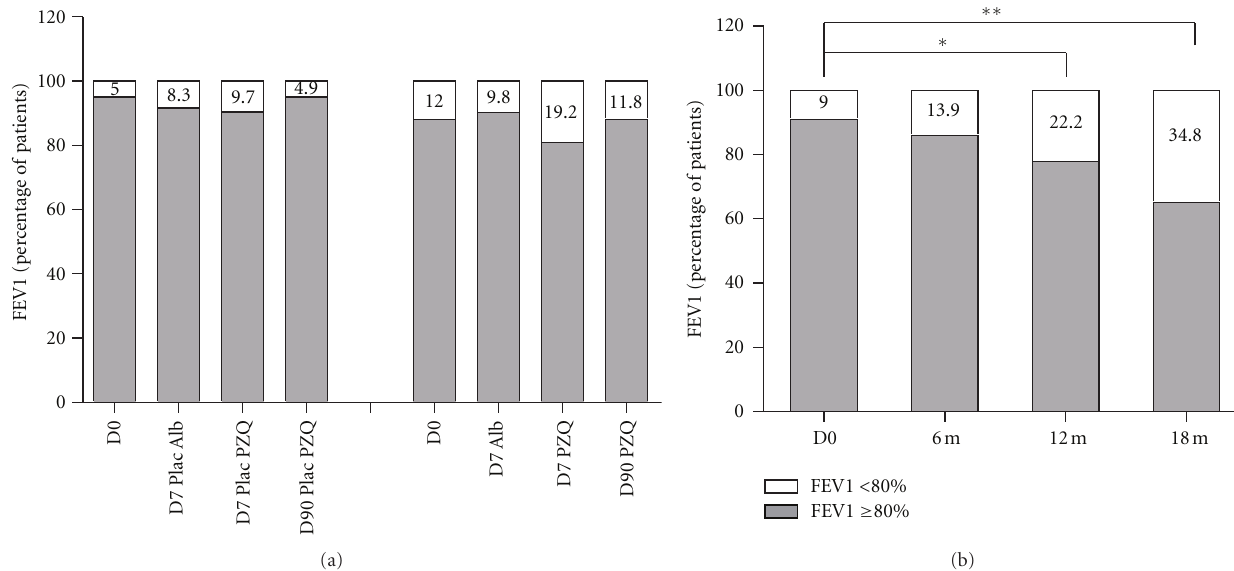
Figure 4: Frequency of Forced Expiratory Volume in 1 second (FEV1) < 80% at D0, D7 after placebo of Albendazole treatment and D7 and D90 after placebo of Praziquantel treatments in the Group 1 and after treatments with Albendazole and Praziquantel in the Group 2 (Figure 4(a)). Frequency of FEV1 < 80% at day zero (D0) and 6, 12 and 18 months after treatment with Albendazole and Praziquantel (b). Results were considered as normal when FEV1 value was ≥ 80%. Numbers in the top of the bars represent the percentage of patients who had FEV1 < 80%. ∗ D0 versus 12 m, P < 0 . 05; ∗∗ D0 versus 18m, P = 0 . 0001; Fisher’s exact